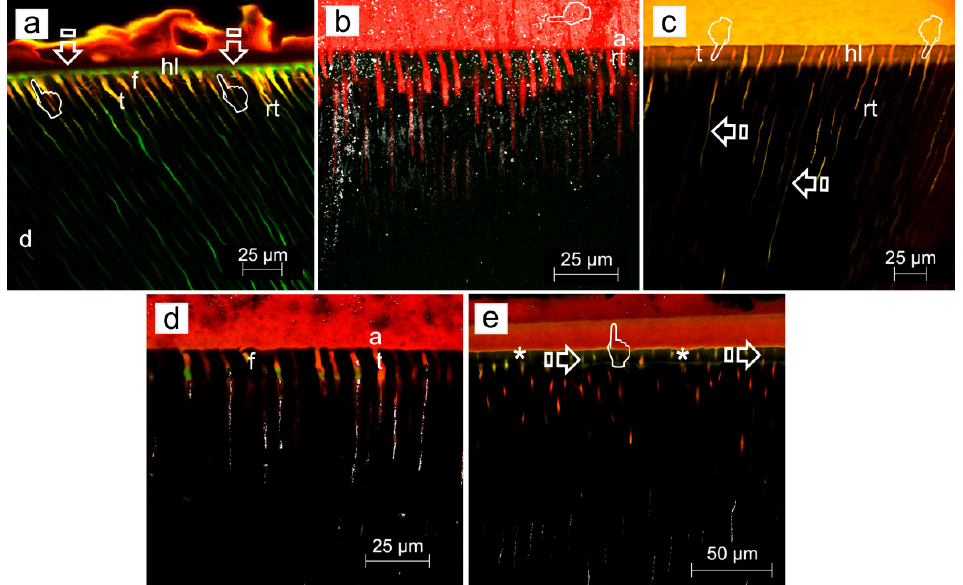
Figure 3. ( a ) Confocal laser scanning microscopy (CLSM) image (reflexion/fluorescence) of the resin-sound dentin interface created using phosphoric acid and Single Bond etch-and-rinse adhesive (PA+SB), after 24 h of storage, showing micropermeability (arrows) between dentin ( d ) and the adhesive layer ( a ). A strong spectral overlap (yellow) corresponds with patent signs of nanoleakage (pointers) at the hybrid layer (hl) (Scale bar: 25 µ m). ( b ) A definitive lack of signs of nanoleakage is characterized, where both no penetration of fluoroscein throughout the proximal ends of dentinal tubules and water sorption in the thickness of the rhodamine B-labeled adhesive ( a ) can be observed when PA+SB-ZnCl 2 is used (Scale bar: 25 µm). ( c ) CLSM image (reflexion/fluorescence) showing the interfacial characterization and micropermeability of the resin/caries-affected dentin interface created using phosphoric acid and Single Bond adhesive with dye xylenol orange (PA+SB·Xo) (Scale bar: 25 µm). ( d ) CLSM images (reflexion/fluorescence) screening the interfacial characterization and micropermeability of the resin/caries-affected dentin interface created by means of phosphoric acid and Single Bond adhesive ZnO-doped (PA+SB-ZnO) (Scale bar: 25 µm). ( e ) The interfacial characterization and micropermeability of the resin/caries-affected dentin interface created using PA+SB-ZnCl 2 is shown at CLSM image (reflexion/fluorescence). A clear pattern of micropermeability within the dentinal tubules and the adhesive layer (arrows), and between the adhesive layer and the resin composite (pointer) may be pointed out (Scale bar: 50 µm). Previous to adhesive application, bond resins were doped with 0.05 wt% Rhodamine-B, or immersed in 0.5 wt% xylenol orange solution. Fluorescein was activated by blue light (488–495 nm) and emitted yellow/green (520 nm). The ultramorphology evaluation (resin-diffusion) was executed using Rhodamine excitation laser. Fluorescences were not separated into spectral regions to permit the operator a full control of the region of the light spectrum directed to each channel. More information about the used CLSM technique is provided at reference [31].